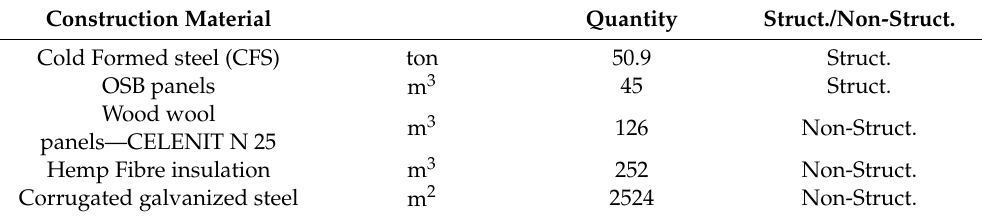
Table 7. Bill of materials: